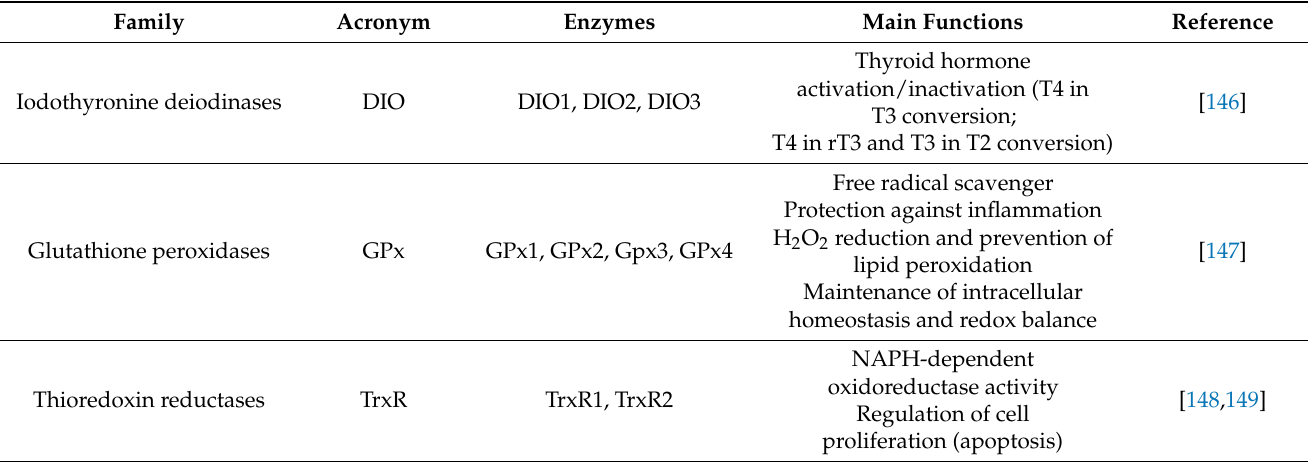
Table 3. Key selenoproteins relevant for thyroid pathophysiology.